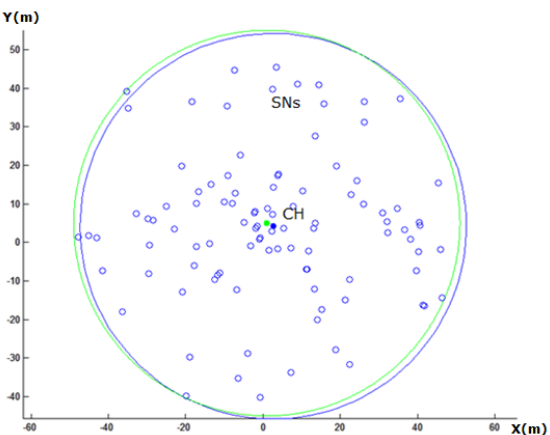
Figure 3. The CH position before and after the adjustment, marked with a dot colored with blue, green, respectively.